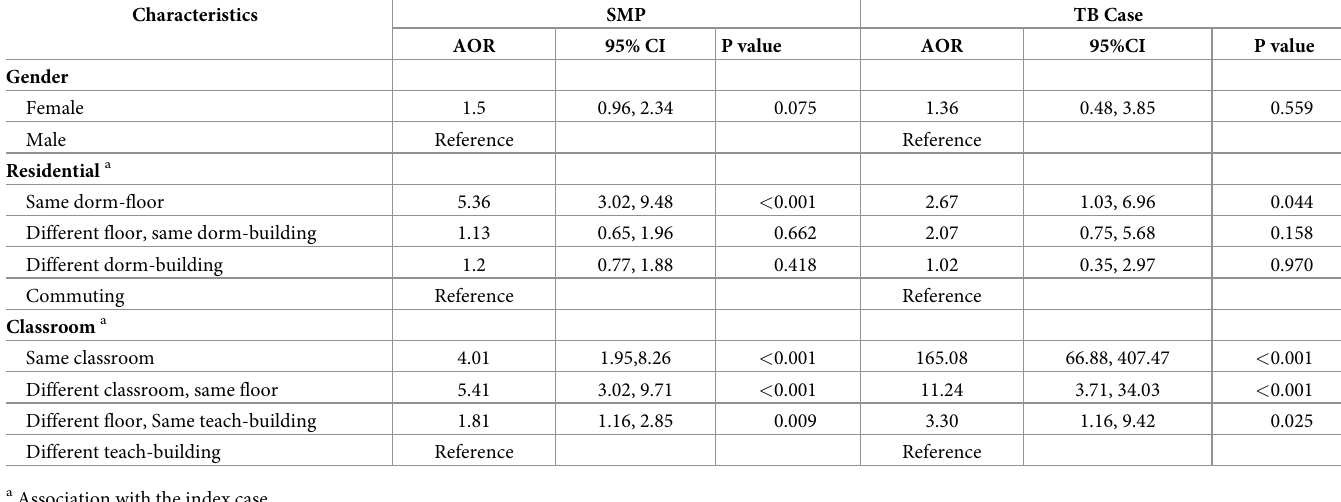
Table 7. Adjusted OR and 95% CI for characteristics of students on SMP and TB cases.